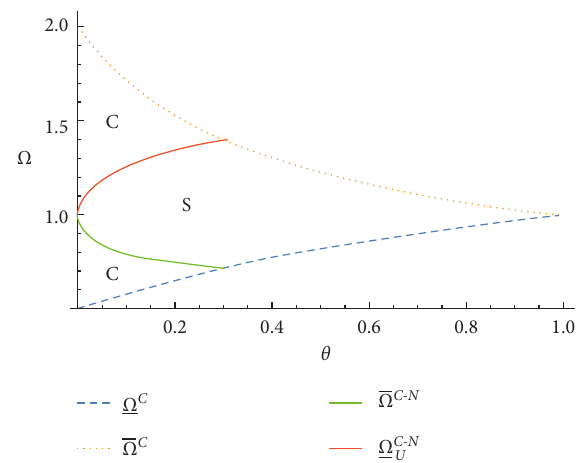
Figure 5: Cooperation preference of